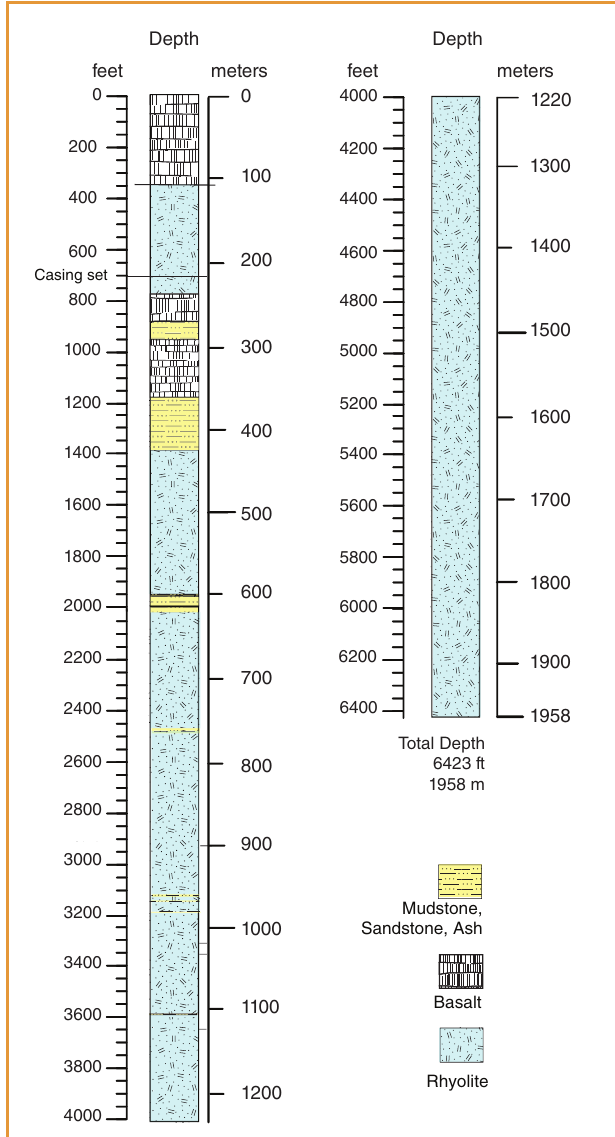
Figure 4. Lithologic log of the Kimberly